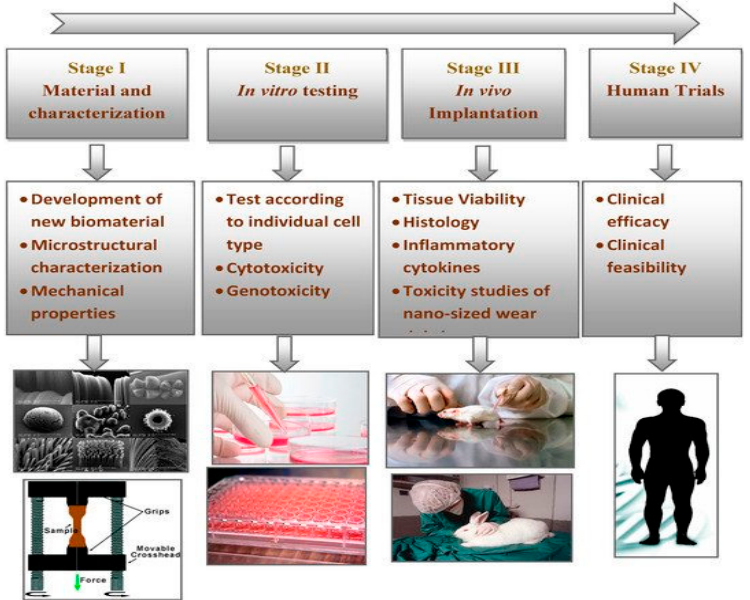
Figure 1. Multiple stages involved in the assessment of newly developed biomaterials for bone tissue engineering. Reproduced from [2] with permission of MDPI under the conditions of Creative Commons Attribution license.